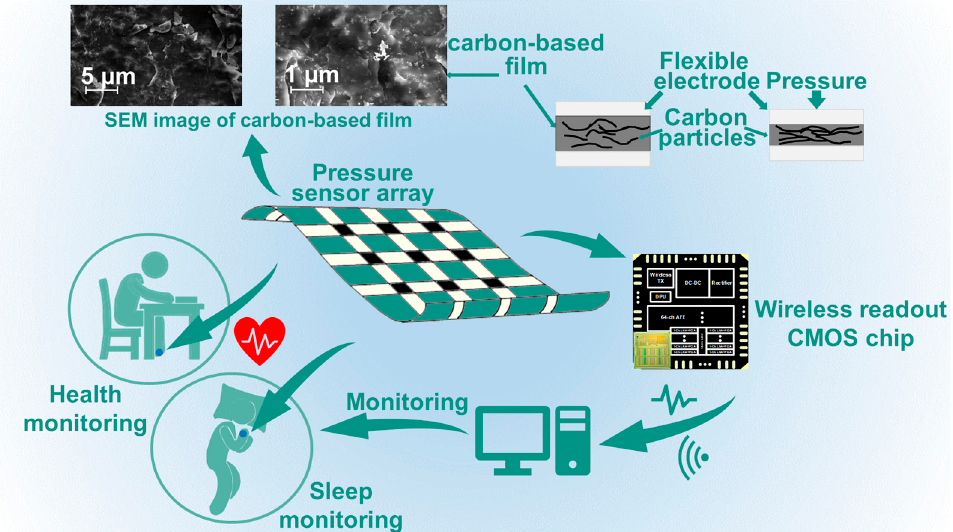
Figure 1. Overview of the remote health monitoring system with a flexible resistive pressure sensor array and a wireless multi-channel signal readout chip.